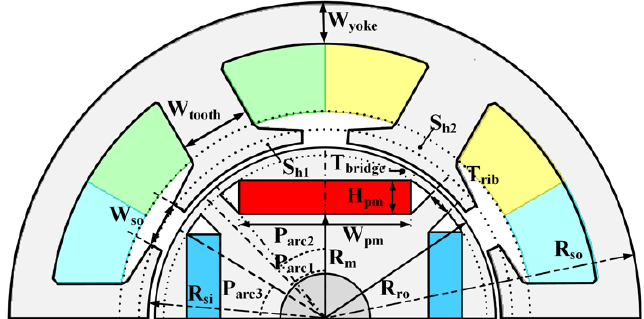
Figure 6. The parameter of the equivalent magnetic circuit method for the magnetic saturation of the bridge region.